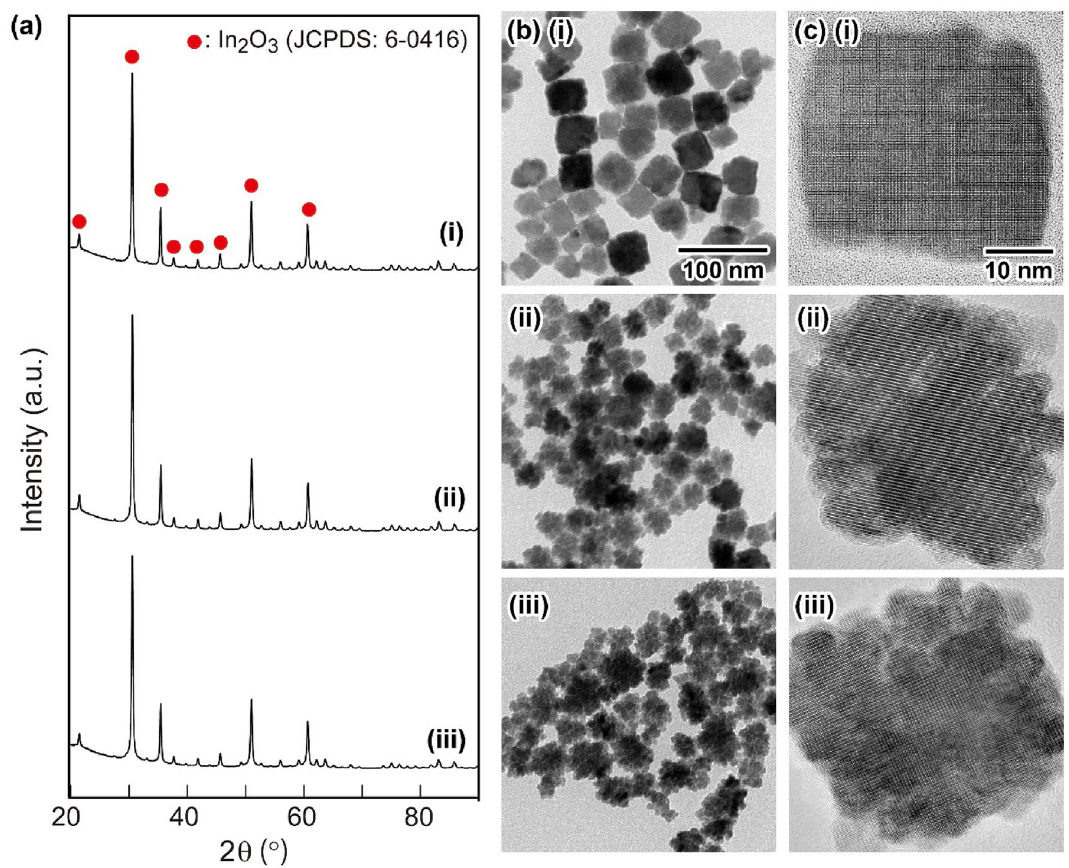
Figure 1. ( a ) XRD patterns of the ITO samples for the NP-mist deposition method: (i) C1 , (ii) P1 , and (iii) P2 . ( b ) TEM images of (i) C1 , (ii) P1 , and (iii) P2 , and (c) HR-TEM images of (i) C1 , (ii) P1 , and (iii) P2 .